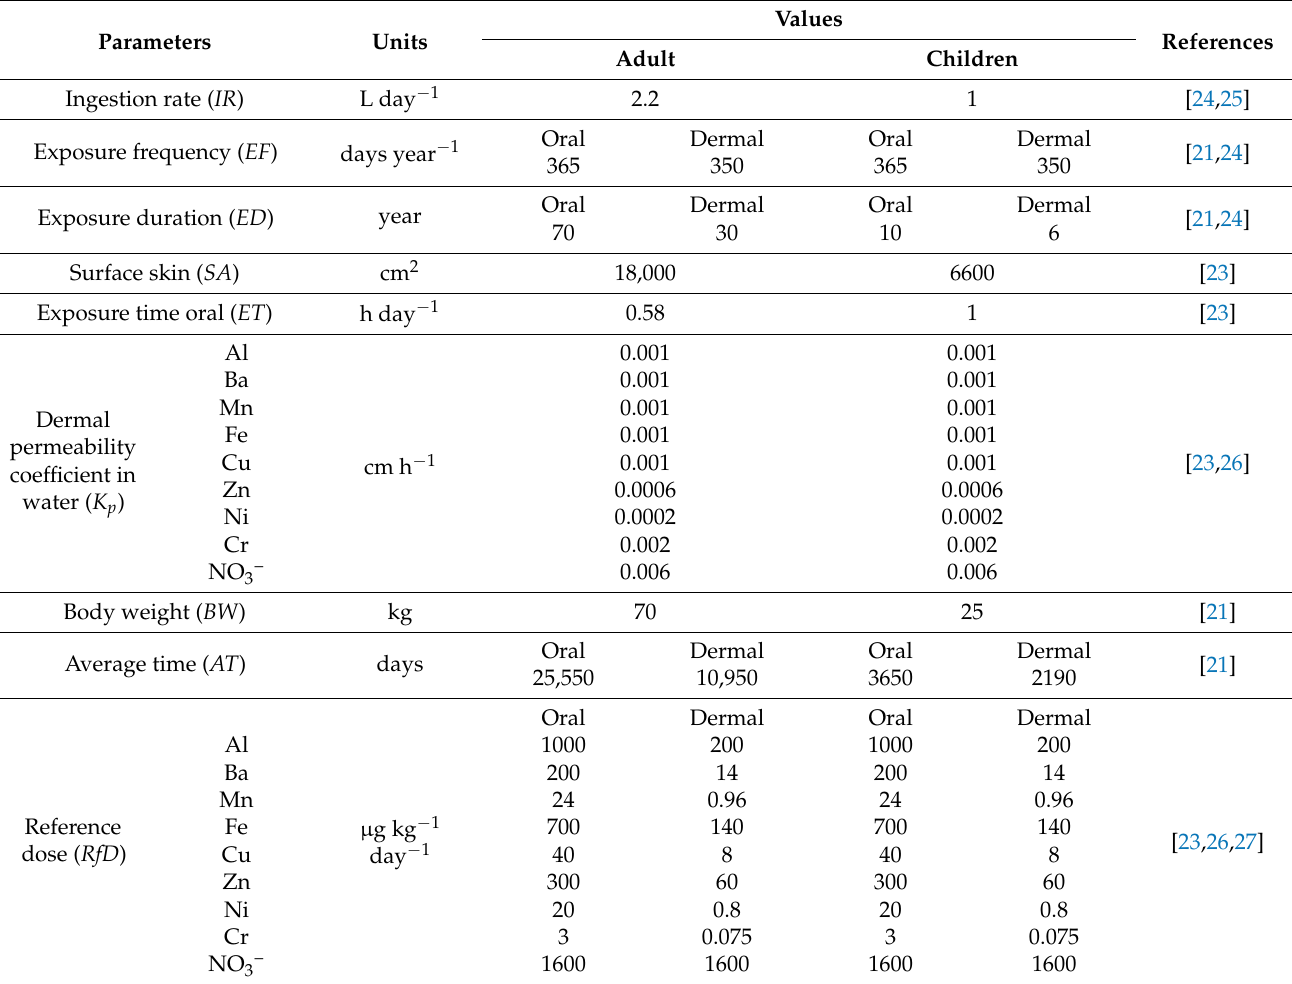
Table 4. Input variables used to calculate the Hazard Quotient for adults and